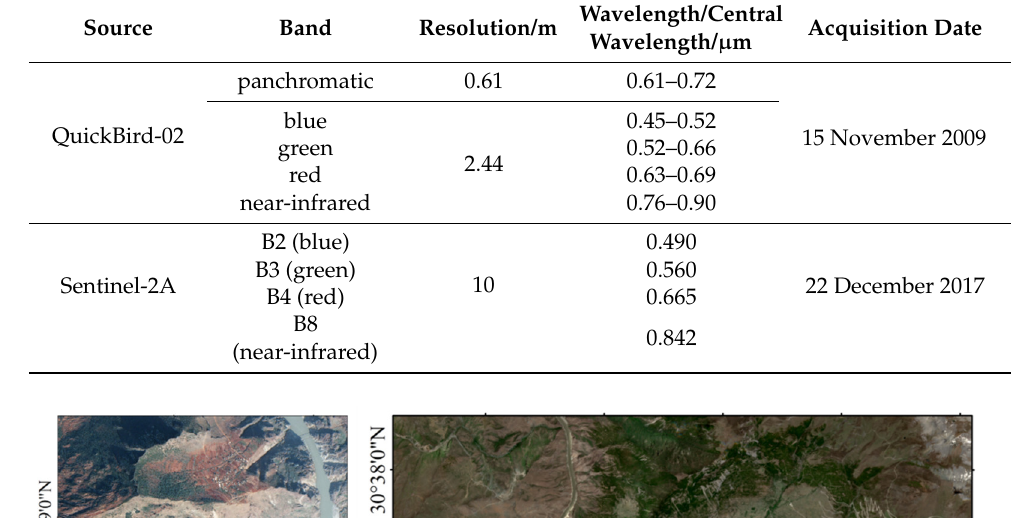
Table 2. Parameters of optical imagery used in this study.